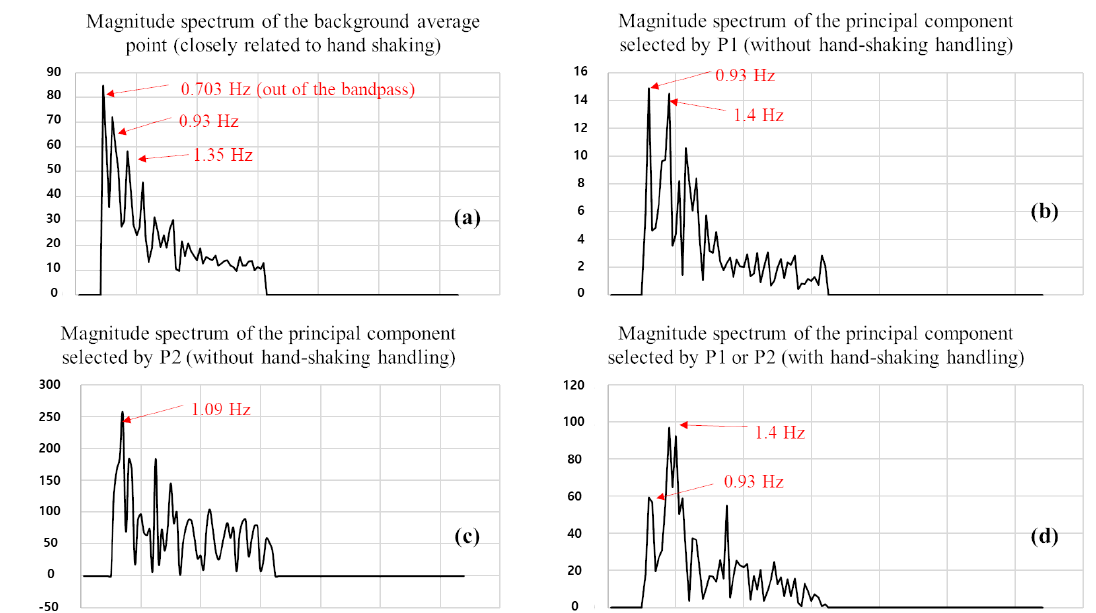
Figure 7. Spectrum analysis of background average point signal and selected principal component signals. These signals were brought from a case where the ground-truth heart rate (from the Polar H7) was 80 BPM ( ≈ 1.33 Hz). In ( b , c ), the hand-shaking-related frequencies of ( a ) mislead the position of the highest frequency. In ( d ), by suppressing the hand-shaking noise, the highest frequency is much closer to the true heart rate.